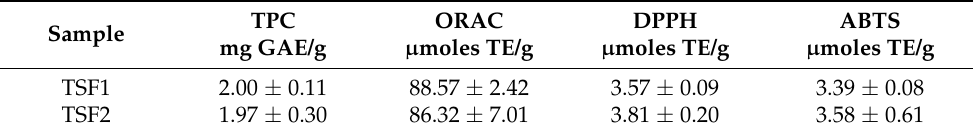
Table 2. Total phenolic content and free radical scavenging capacities of tomato seed flour extracts.